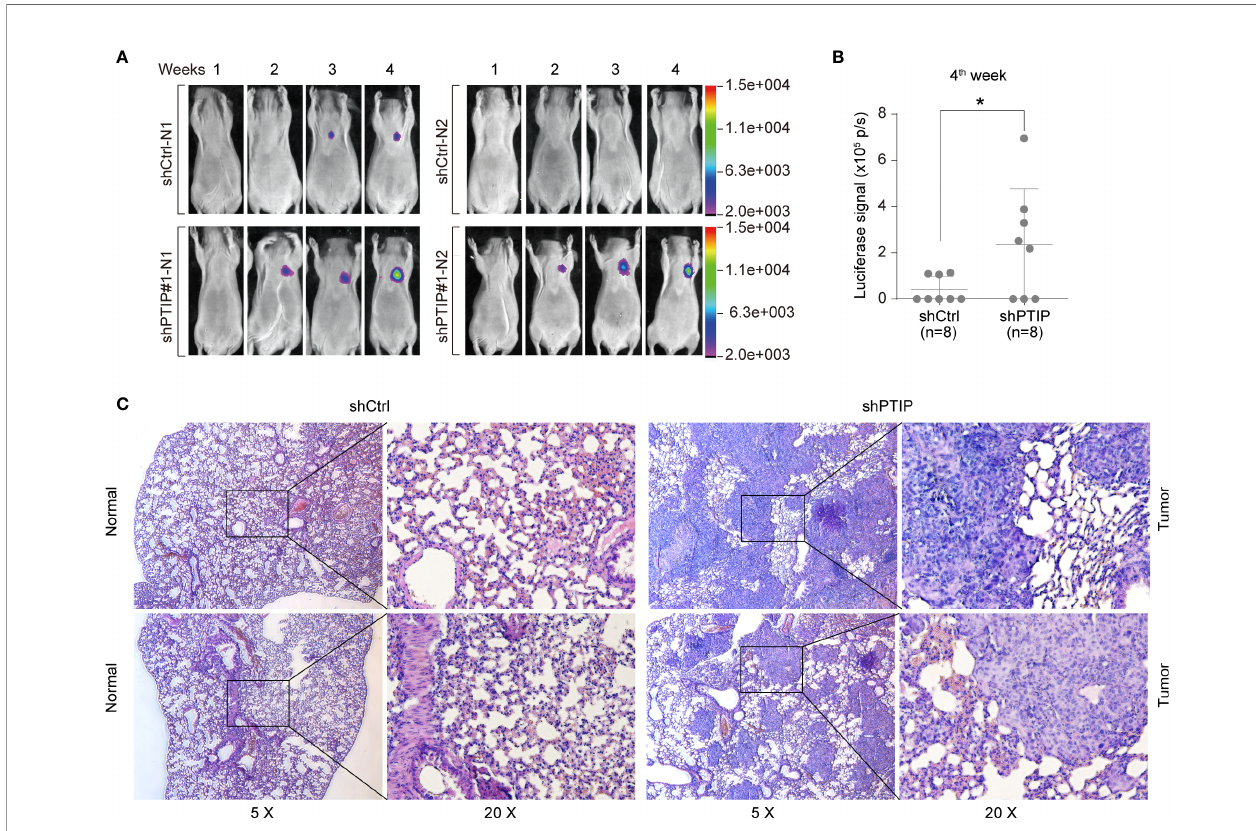
FIGURE 3 | PTIP inhibits ESCC cell invasion and migration in vivo. ( A, B ) The effect of PTIP knockdown on tumor growth and metastasis in a mouse model based on tail vein injection. KYSE-150 cells were infected with Scrambled shRNA (shCtrl) or shPTIP#1 lentivirus containing a constitutively expressed luciferase reporter. Then, shScrambled-treated or shPTIP cells were injected into mice via tail veins(n=8), and lung metastases in the two groups were evaluated by an in vivo imaging system(In-Vivo FX PRO). The luciferase signals were compared between the shCtrl group and the shPTIP group. Unpaired, two-tailed Student ’ s t-test; * P < 0.05. (C) Metastatic lesions in lungs from mice at the 4 th week were analyzed by H&E staining. Overall staining patterns were shown at low magni fi cation (original magni fi cation ×5) as a composite fi gure and zoomed views (original magni fi cation ×20) of the indicated areas